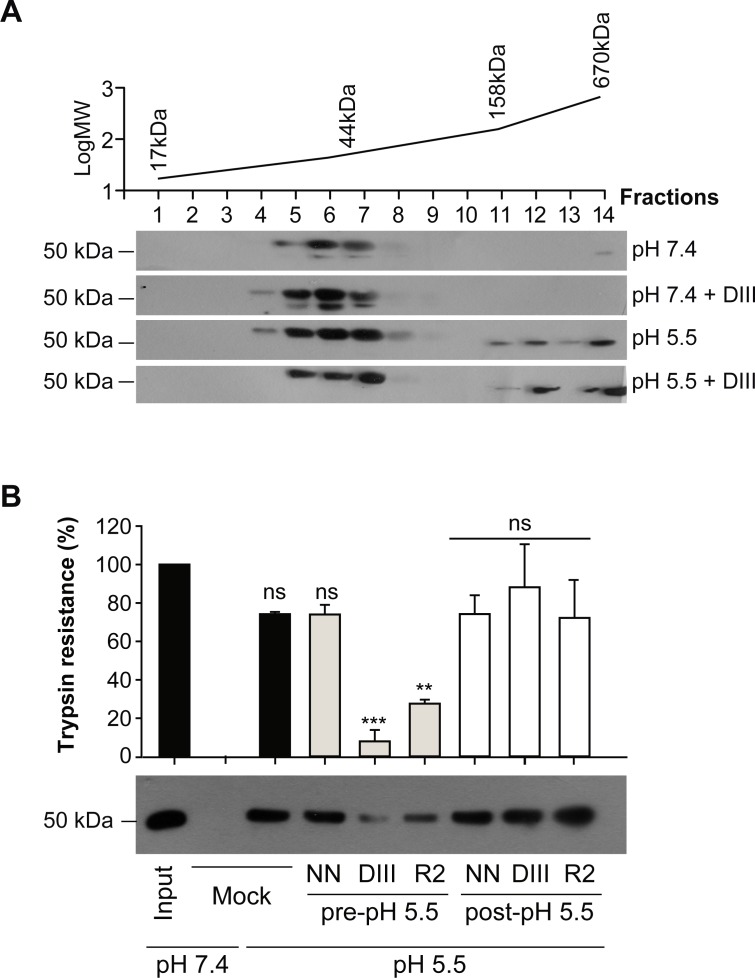
Exogenous DIII and stem fragments interfere with the formation of a stable post-fusion Gc trimer.(A) Low pH-induced multimerization changes of ANDV Gc in the presence or absence of exogenous DIII assessed by sucrose gradient sedimentation. ANDV was incubated for 30 min at pH 7.4 or pH 5.5, with or without ANDV DIII (6 μM). The presence of Gc in each fraction of the gradient was assessed by western blot analysis. The top panel indicates the sedimentation of molecular mass markers. (B) Gc homotrimer stability in the presence or absence of exogenous DIII and stem fragment R2. ANDV VLPs were incubated at the indicated pH and DIII (6 μM) or R2 (20 μM) added before or after acidification. After back-neutralization, the VLPs were treated with trypsin for 30 min and the digestion of Gc was assessed by western blot analysis. The trypsin resistance of Gc was quantified by densitometry (n = 3) and the statistical evaluation performed in relation to the input:***, P < 0.00025; **, P < 0.0025; *, P < 0.025; ns, not significant.